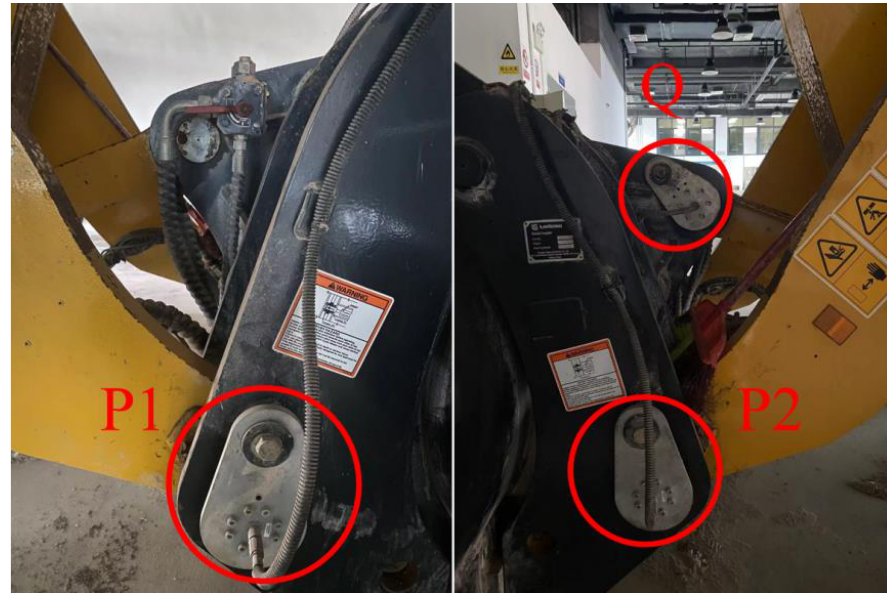
Figure 4. Shaft-pin-type sensor.